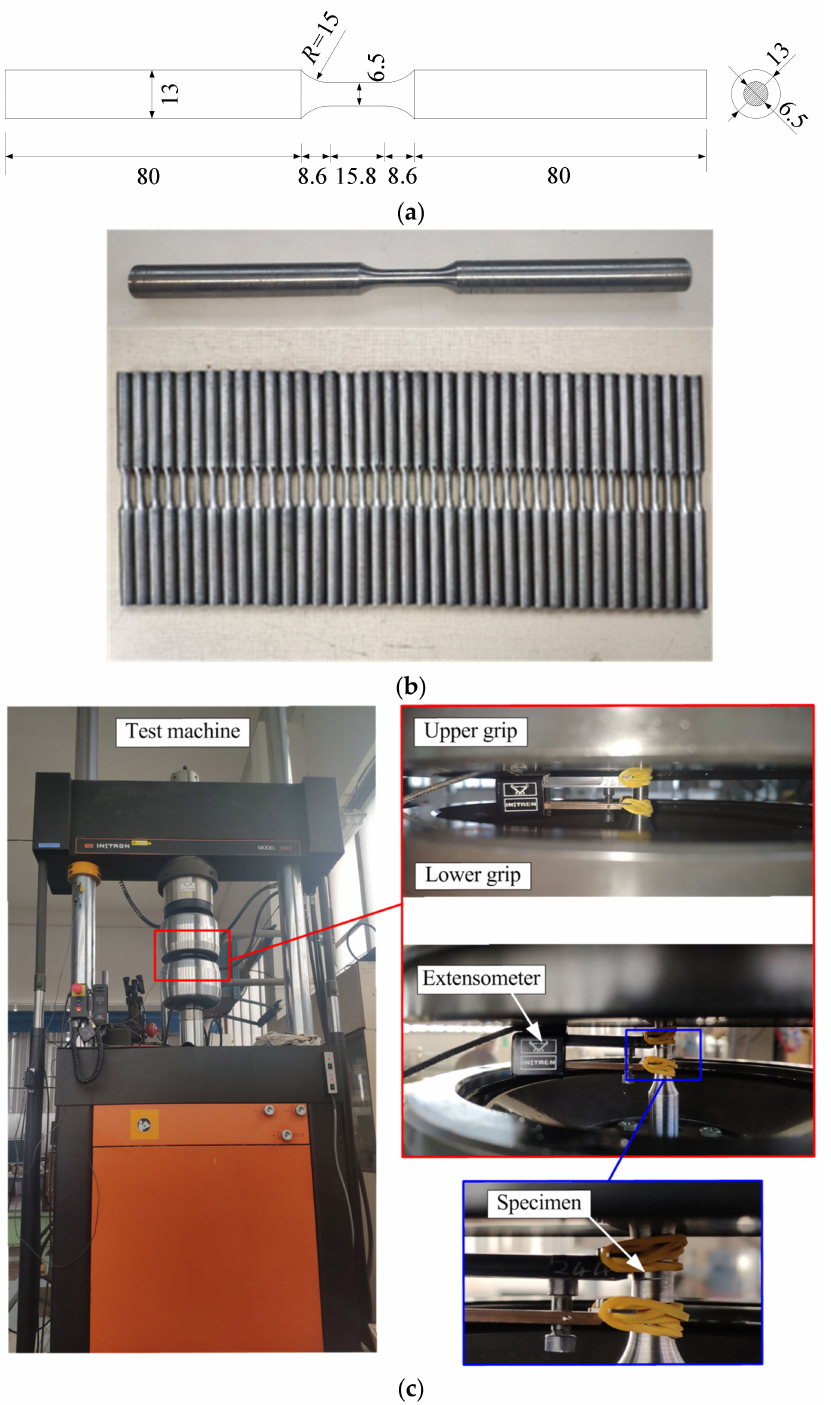
Figure 1. Material specimens and test setup: ( a ) shape and size of the specimen (Unit: mm); ( b ) photos of the specimens; ( c ) test machine and strain